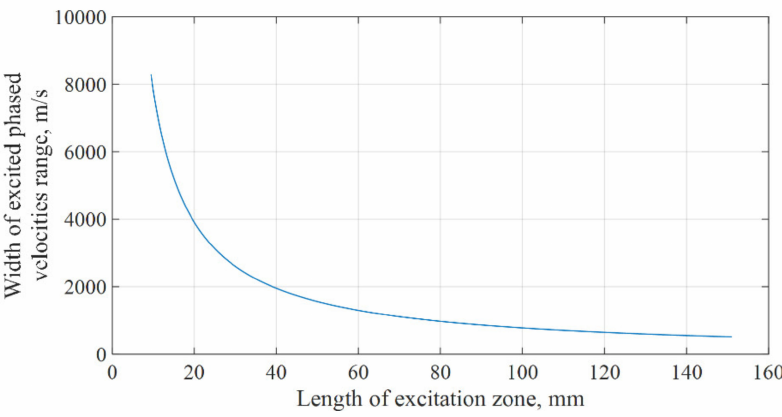
Figure 8. Bandwidth of excited phase velocities versus the length of excitation